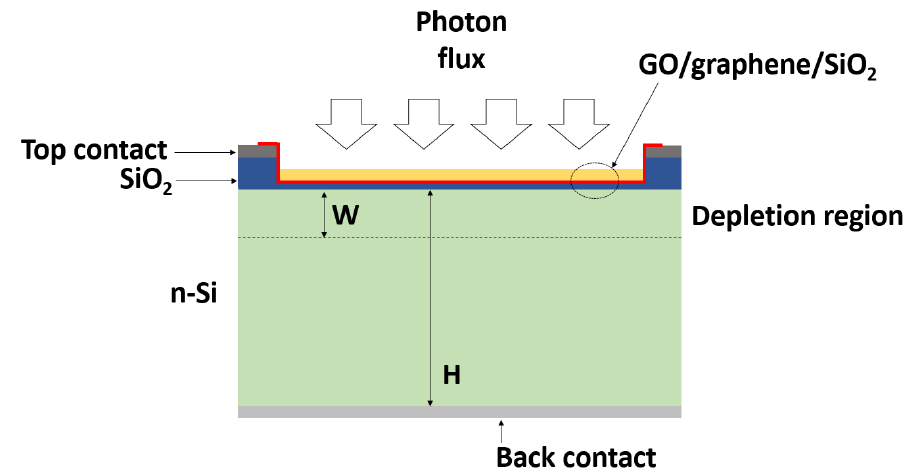
Figure 1. Cross section of the designed Schottky junction solar cell. GO: graphene oxide.